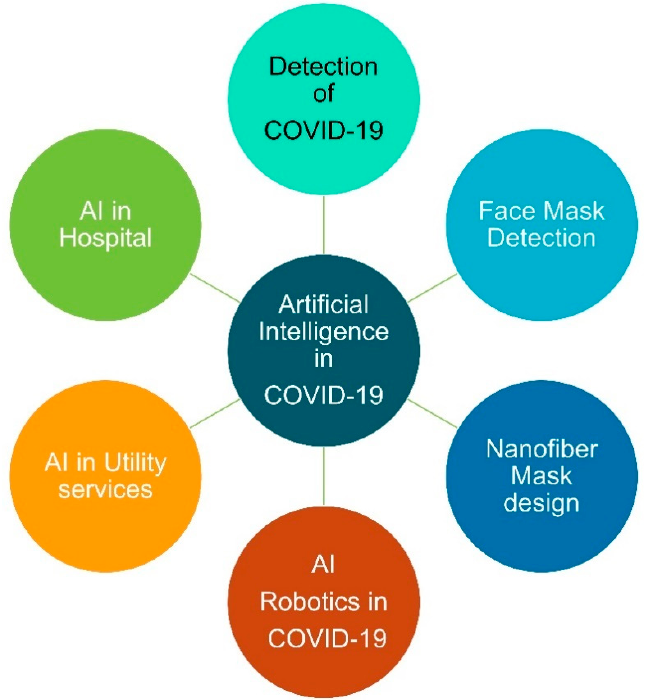
Figure 3. AI and its applications in various healthcare fields discussed in this